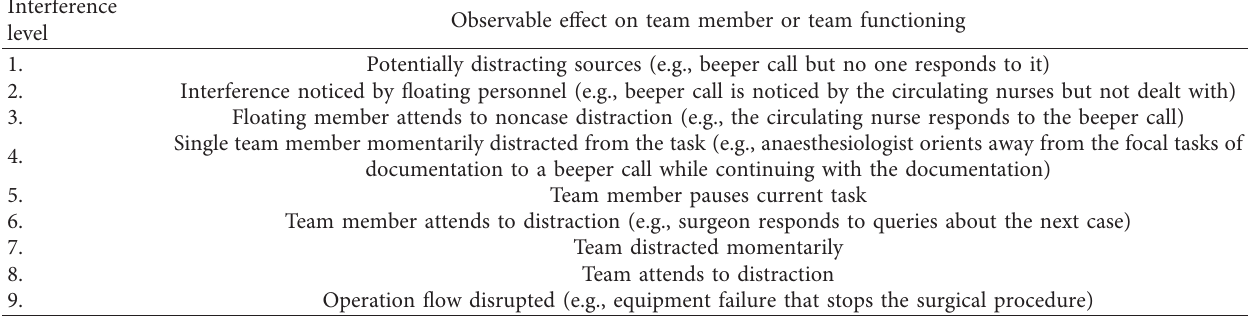
Table 1: Ordinal scale used to assign an interference score to each observed